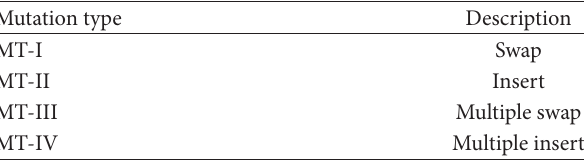
Table 5: Mutation probability.